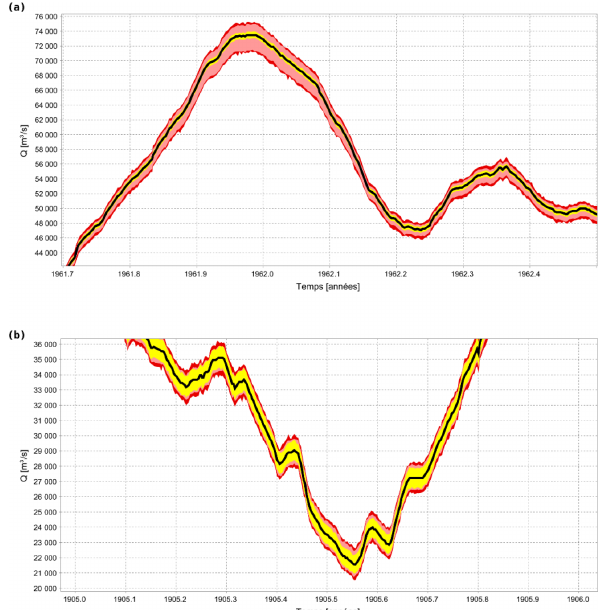
titude sur les hautes eaux est toutefois peut-être sous-estimée